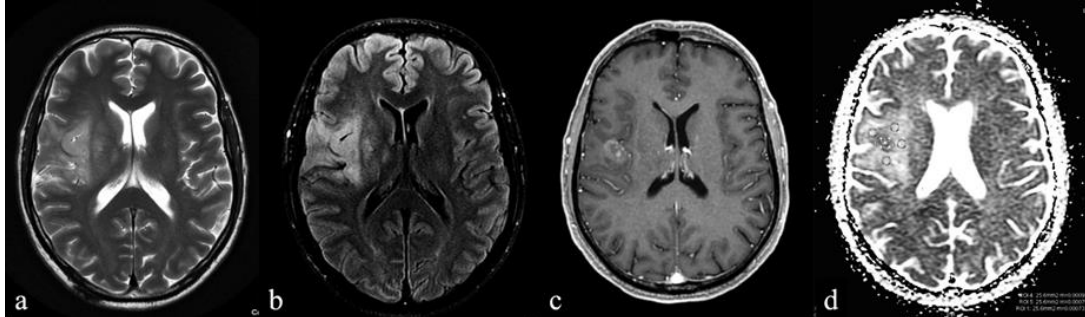
Figure 2. A 60-year-old man with an anaplastic astrocytoma IDH-Wt. ( a , b ) Axial T2-weighted and FLAIR images demonstrate a lesion with high signal intensity and indistinct borders on the right insular lobe; contrast-enhanced axial T1-weighted image ( c ) demonstrates a blurred contrast-enhancement within the lesion corresponding to the lower mean ADC (ADCm) value ( d ). Scale bar: 5 cm.